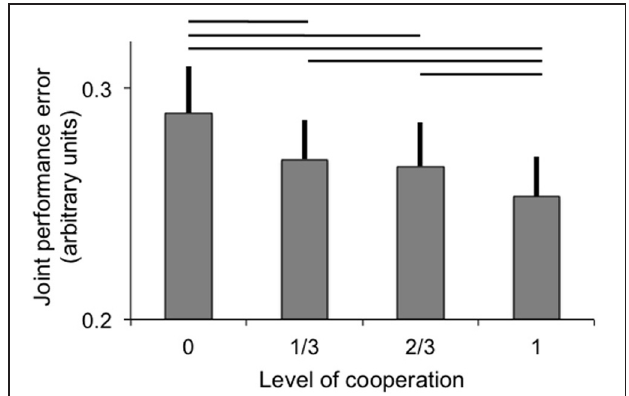
FIGURE 2 | Joint performance error (arbitrary units; error bar: standard error) as a function of the level of cooperation. Horizontal lines indicate significant pairwise comparisons ( p < 0 .